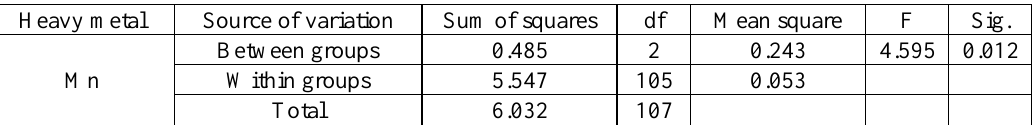
Table 12. One way ANOVA for groundwater